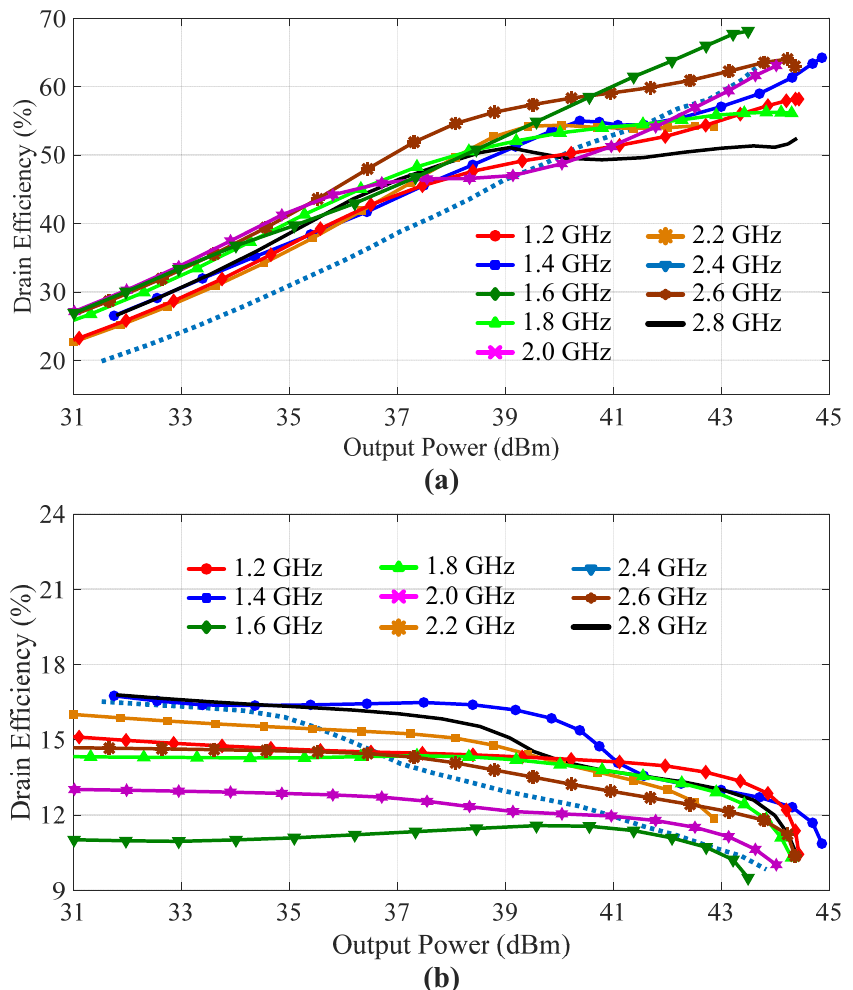
Figure 8. Simulated ( a ) drain efficiencies and ( b ) gains of the designed DPA versus output power at different